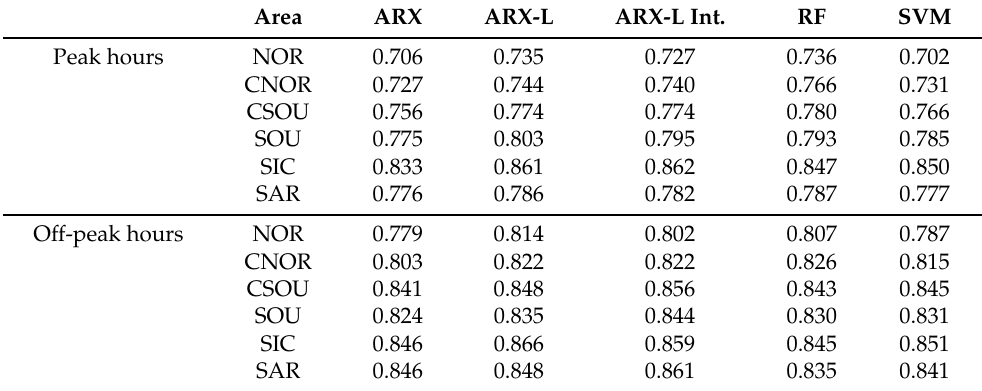
Table 2. Comparison of forecasting performances to those of the RW model over peak (14 h) and off-peak (10 h) hours. Values are obtained as the ratio of the model’s average RMSE to the average RMSE under the Random Walk assumption, over the prediction horizon in the same hour group (peak and off-peak). Area ARX ARX-L ARX-L Int. RF SVM Peak hours NOR 0.706 0.735 0.727 0.736